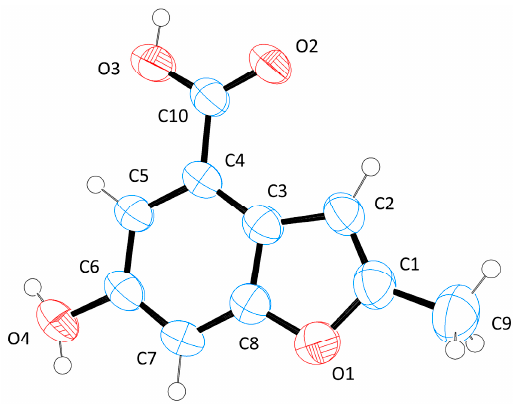
Figure 2. ORTEP plot of 1 , with the arbitrary atom numbering (ellipsoids are at 40% probability and H atoms are represented as spheres of arbitrary radii).